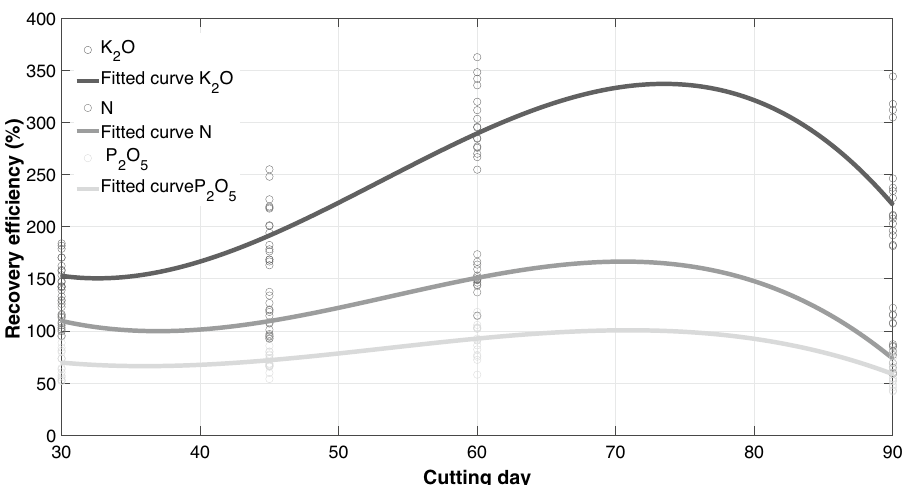
Figure 5. Cubic relationship between nutrient recovery efficiency and cutting day for (a) N (r 2 = 0.903, n = 42, P < 0.001), (b) P 2 O 5 (r 2 = 0.6763, n = 43, P < 0.001), (c) K 2 O (r 2 = 0.7803, n = 46, P < 0.001). Plots were created in MATLAB